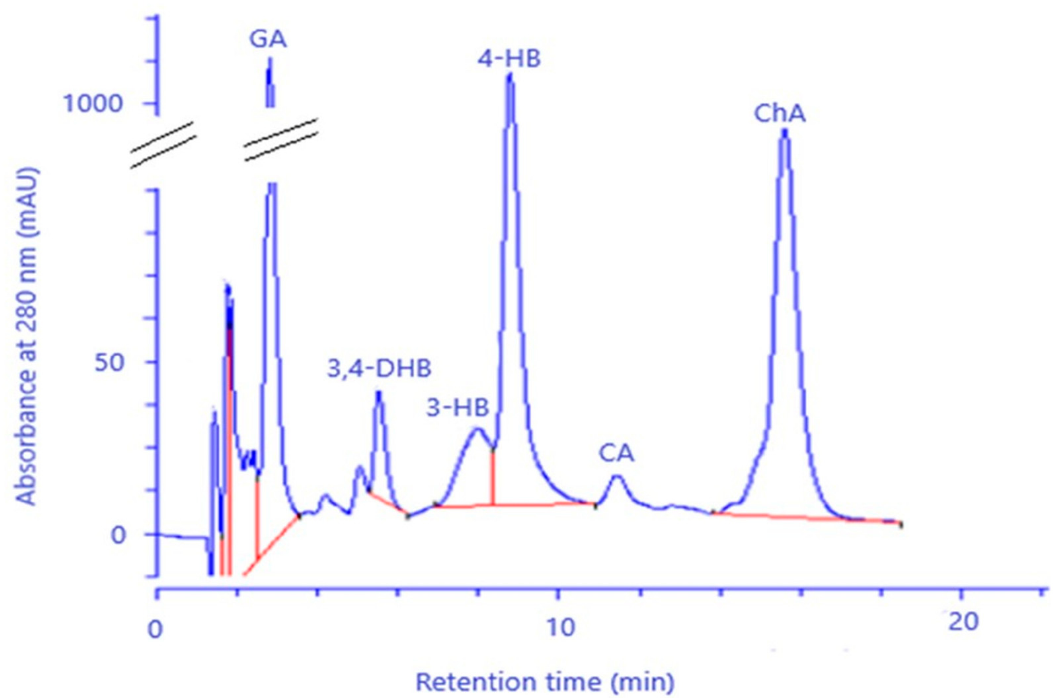
The HPLC method was used to identify and quantify selected phenolic acids in FEE